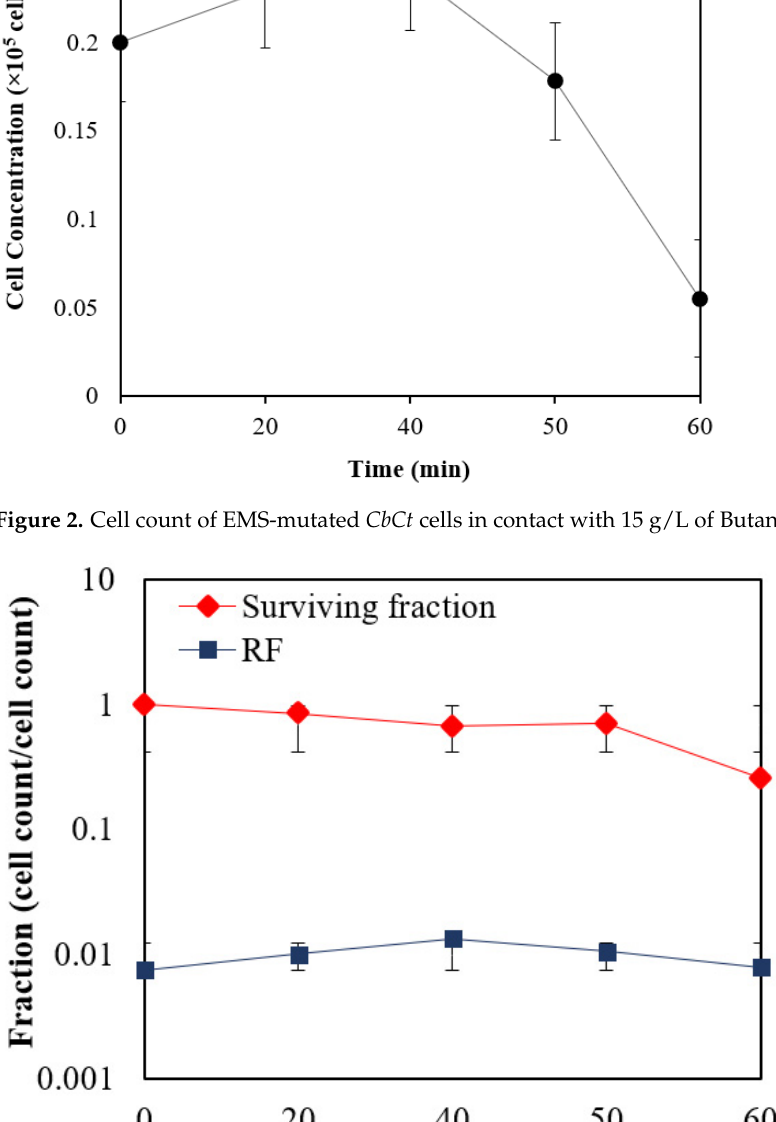
Figure 2. Cell count of EMS-mutated CbCt cells in contact with 15 g/L of Butanol .